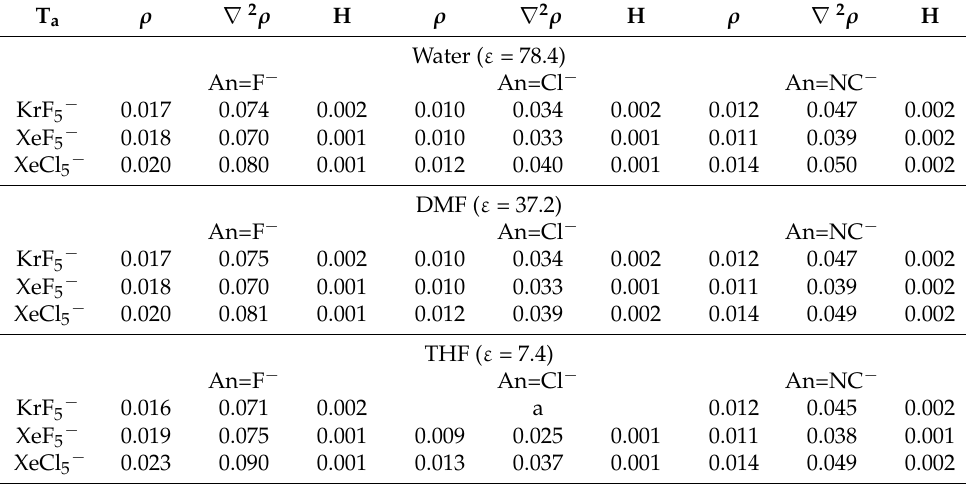
Table 6. QTAIM descriptors of the AeX 5 − ··· R − complexes. Bond critical point (BCP) properties: electron density ρ , Laplacian of electron density ∇ 2 ρ and total electron energy H, were obtained at the MP2/aug-cc-pVDZ level. Data in atomic